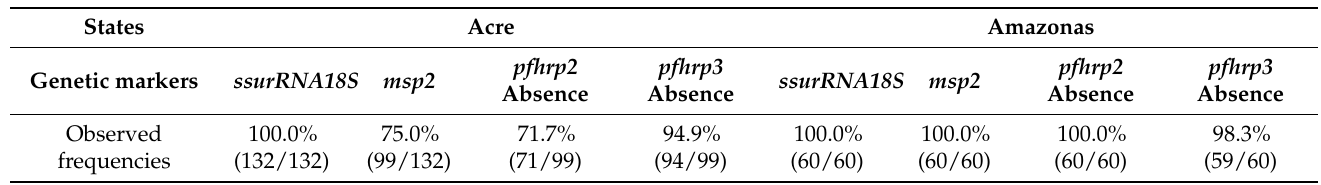
Table 1. Summary of genetic markers and distribution of pfhrp2 and pfhrp3 frequencies in P. falciparum isolates in states of Acre and Amazonas, in Brazil.